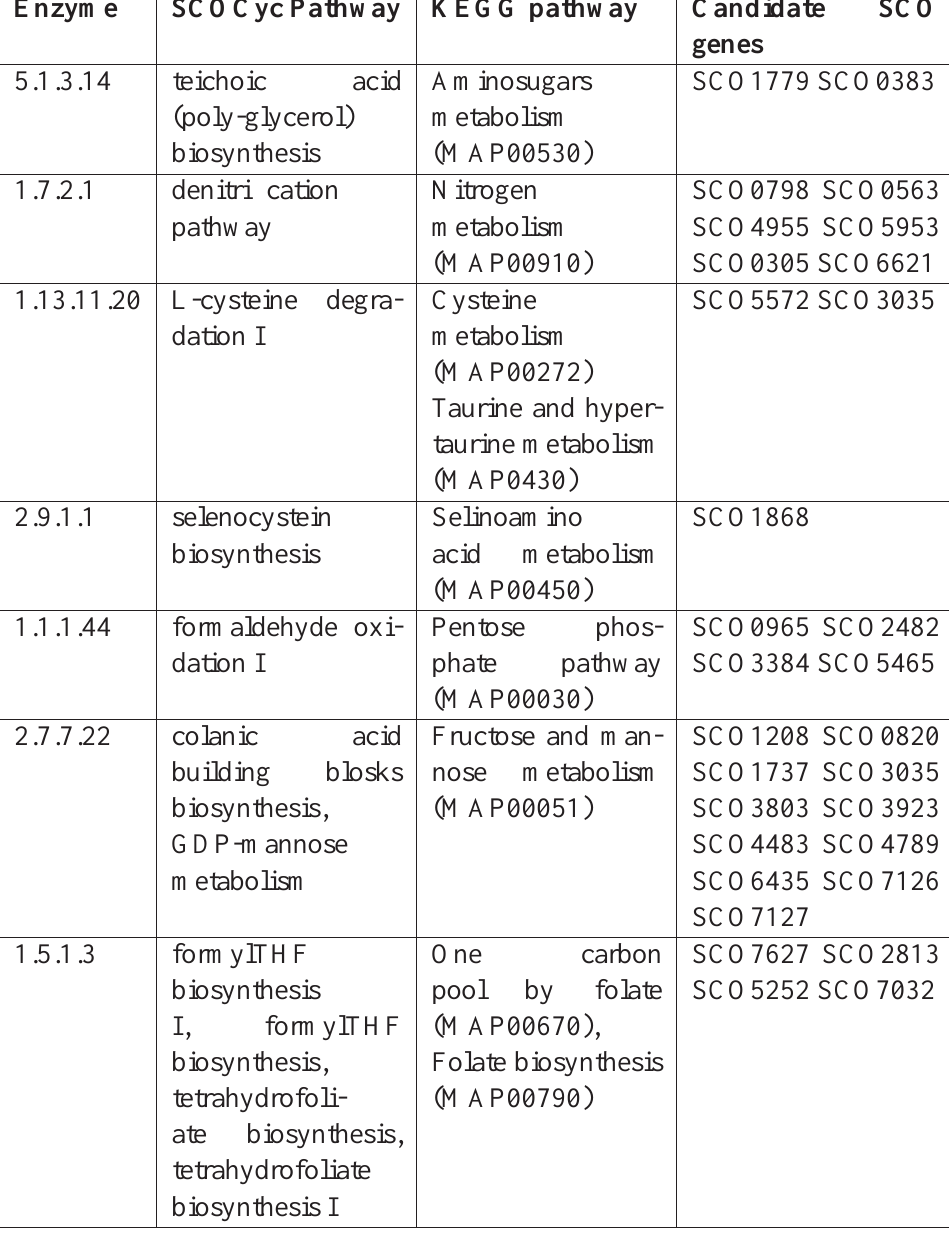
Table 2: Holes identified by HoleFiller and possible candidates identified from sequence